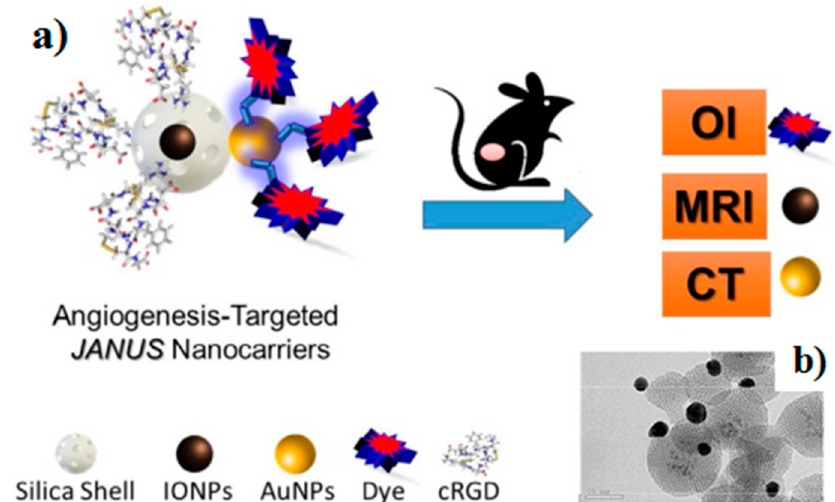
Figure 8. Strategy for multimodal molecular imaging assessment of targeted Janus nanoparticles in tumor-bearing mouse model (OI, optical imaging; MRI, magnetic resonance imaging; CT, computed tomography; IONPs, iron oxide nanoparticles; cRGD, peptide cyclo[Arg-Gly-Asp-D-Phe-Lys]). Reprinted and adapted from Reference [60].